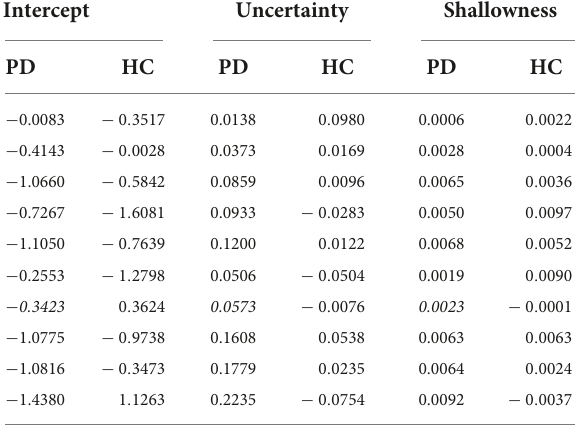
TABLE 6 Regression coefficients for predicting switching time variability from both predicted minimal sensory-motor uncertainty and shallowness of the